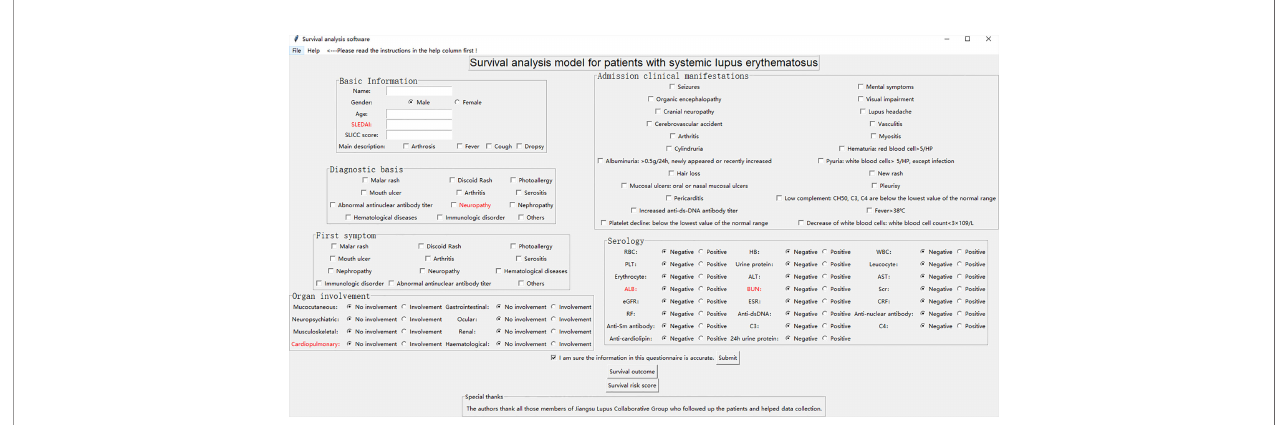
FIGURE 5 | Graphical User Interface of survival